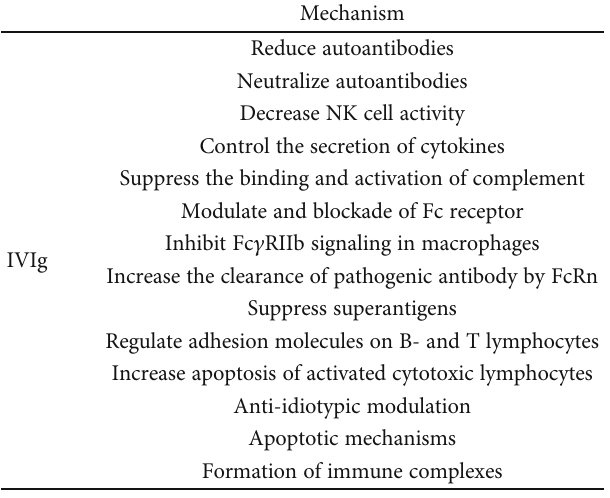
Table 1: Possible mechanisms of intravenous immunoglobulin (IVIg) in the prevention of recurrent pregnancy loss